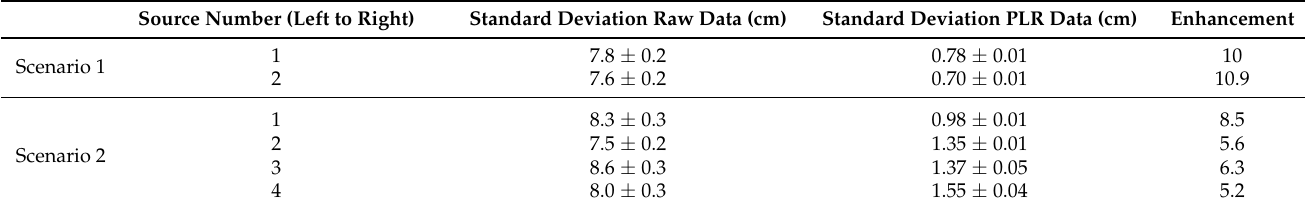
Table 3. The standard deviations of the fitted Gaussians as in Figure